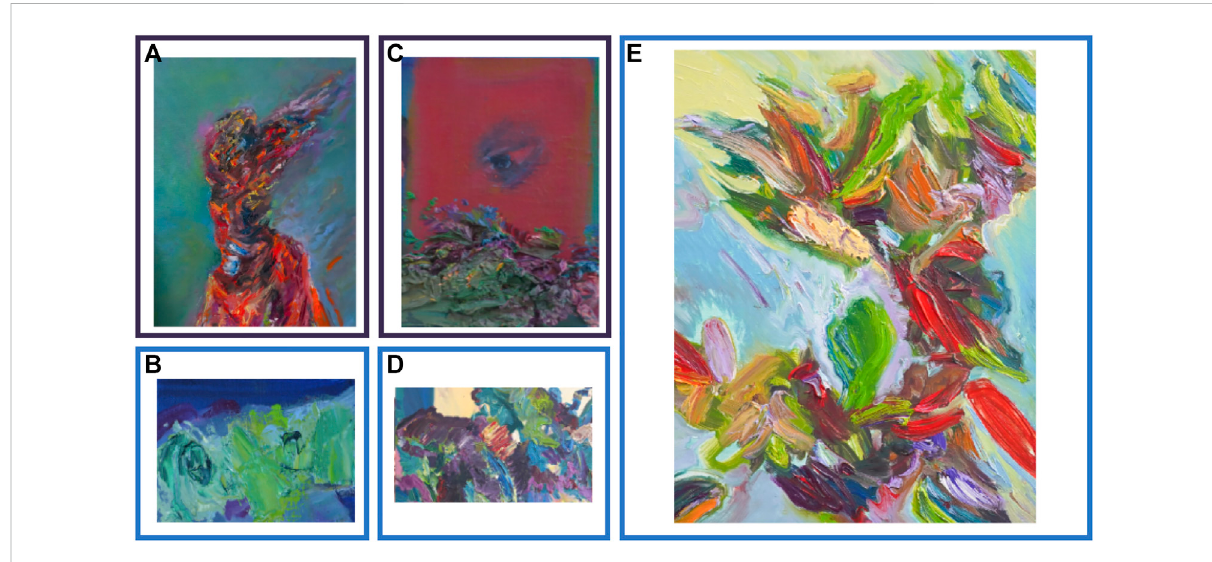
FIGURE 1 Oiloncanvas byPamelaDavisKivelson. (A) WingedVictoryon Fire,2020(16×20), (B) Velocity,2020(4 ×7), (C) Eye,Lake,and Mountains, 2018 (4 × 7), (D) Quantum Braiding, 2020 (8.5 × 14), (E) Angry Sun fl owers 3, 2020 (11 × 14). All fi gures were of similar size in the virtual